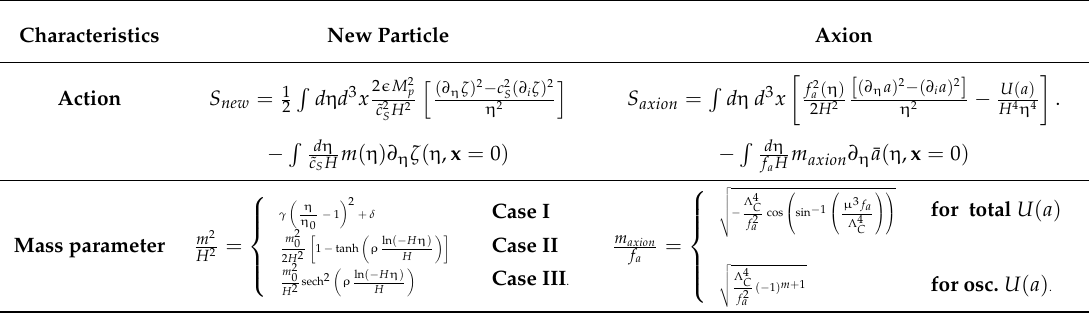
Table 1. The table below shows the analogy between the new particle and axion in string theory. Characteristics New